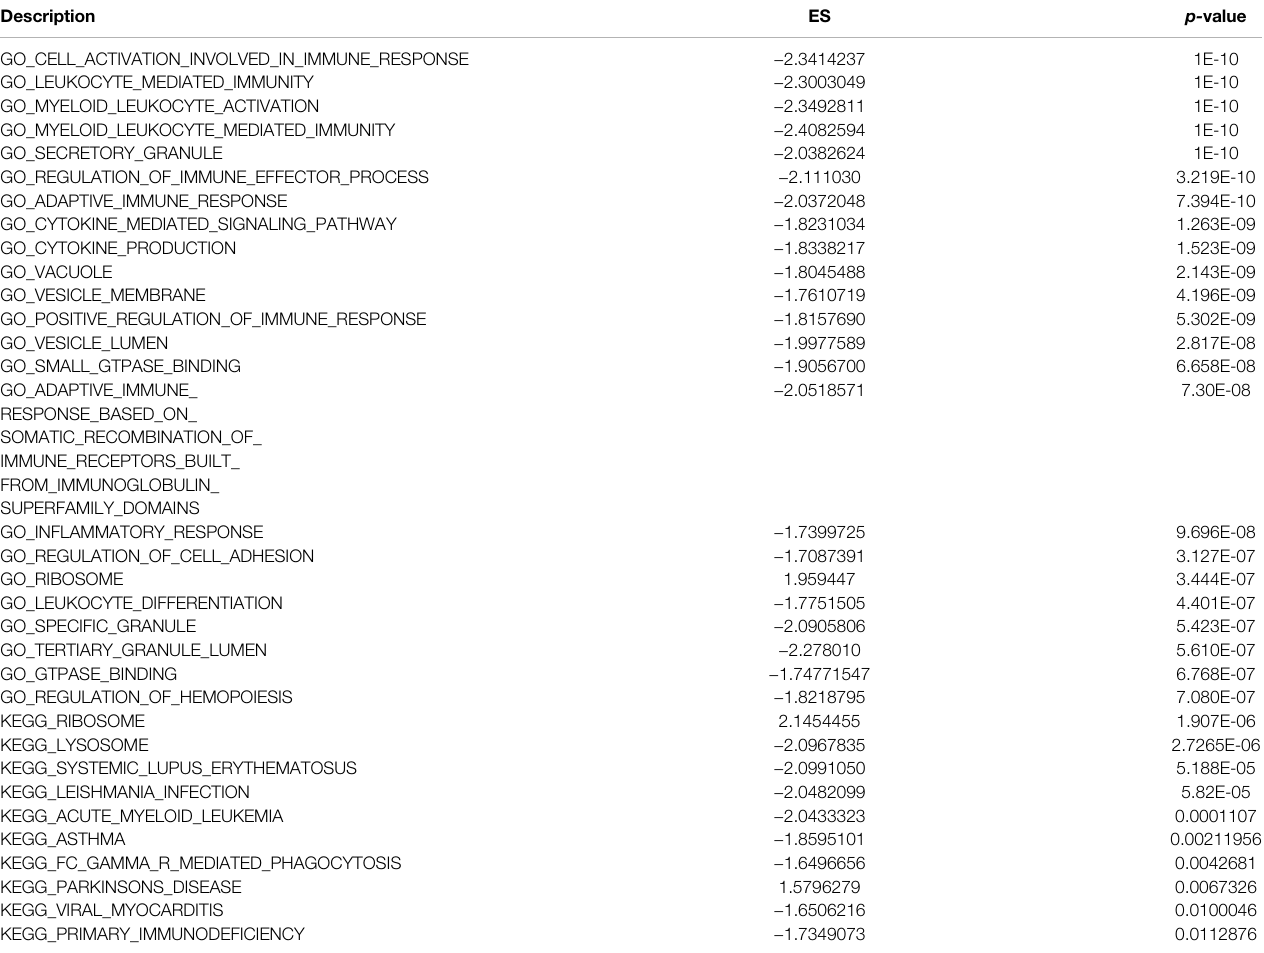
TABLE 6 | GSEA enrichment analysis of the GSE150408 dataset.